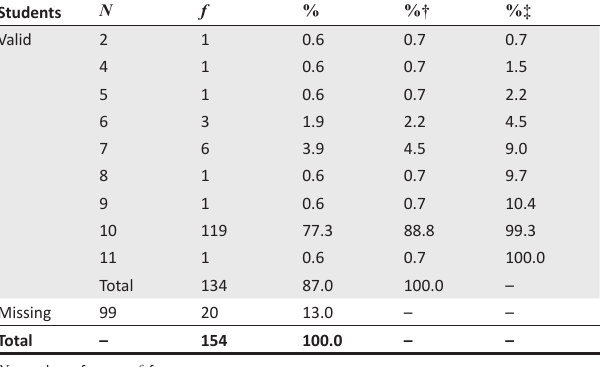
TABLE 3: Students’ performance on pre-test HIV counselling.